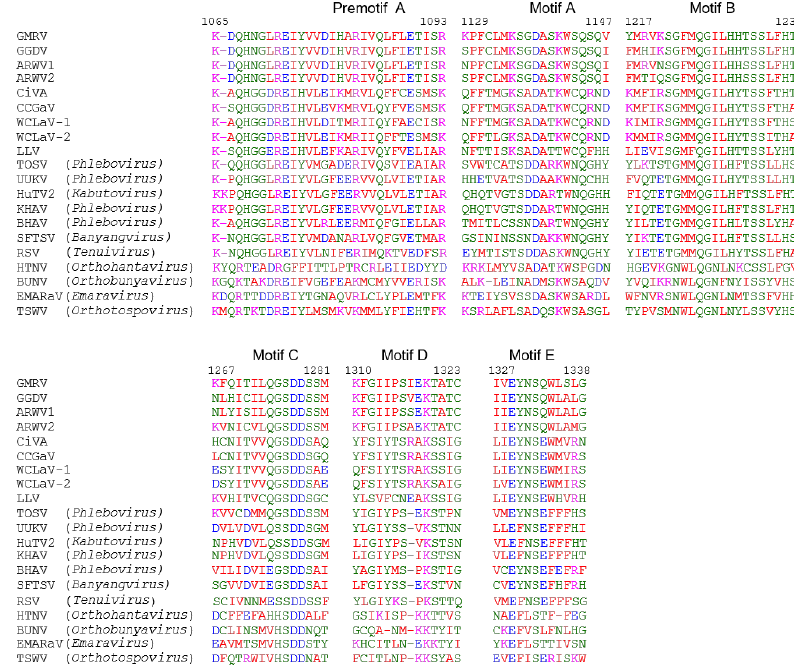
Figure 3. Multiple alignments of RNA-dependent RNA polymerase (RdRp) conserved motifs present in grapevineMuscatrosevirus(GMRV),grapevineGarandmakvirus(GGDV)andothernegative-stranded RNA viruses. Amino acid positions in the GMRV RdRp are reported. ARWV1, apple rubbery